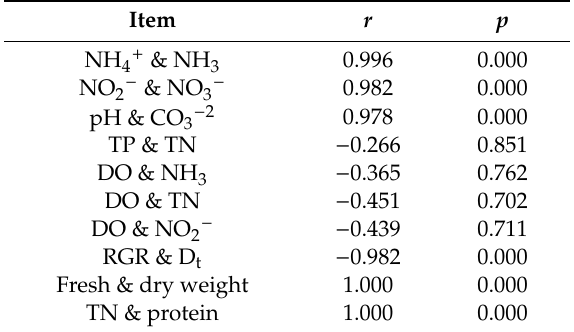
Table 1. Pearson correlation coefficients (r) between each pair of different parameters.